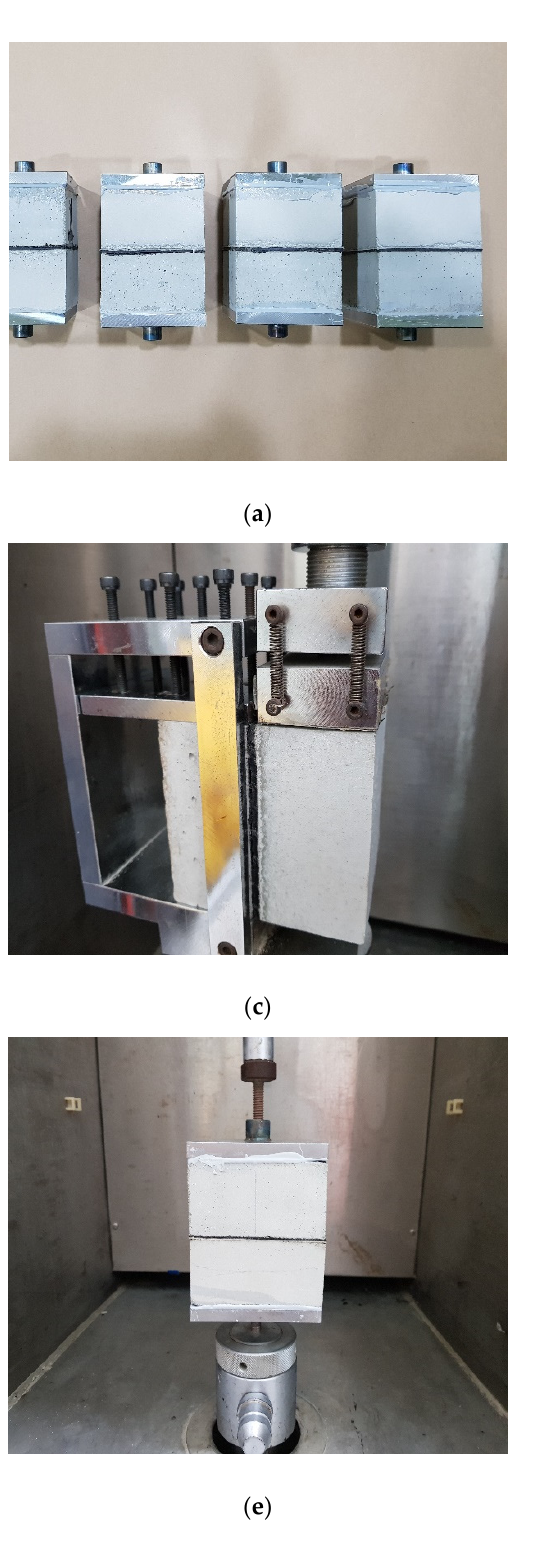
Figure 7. Evaluation of methods of LMC pavement specimens with applied waterproofing sheet; ( a ) LMC specimens, ( b ) water immersion test, ( c ) shear and deformation test, ( d ) shear adhesive and deformation test result, ( e ) tensile test, ( f ) tensile adhesive strength test result.